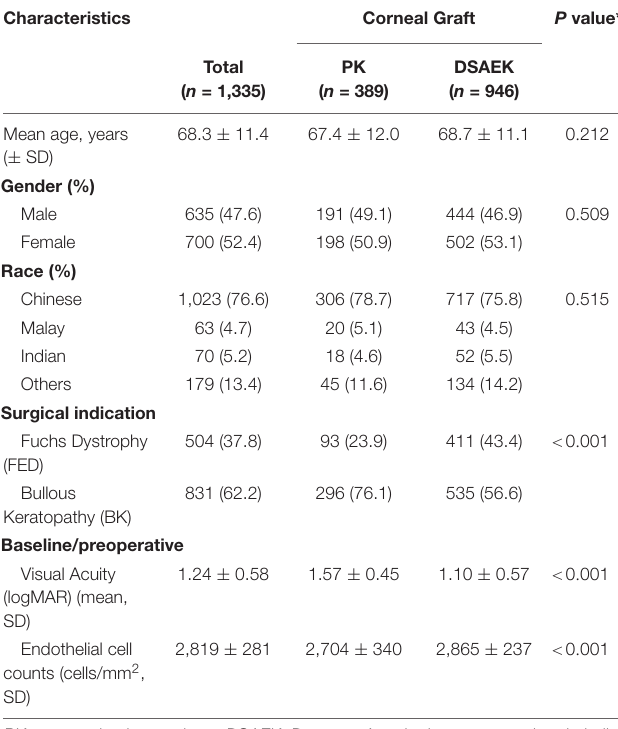
TABLE 1 | Baseline characteristics of study cohort comparing penetrating keratoplasty (PK) and Descemet stripping automated endothelial keratoplasty (DSAEK) from the Singapore Cornea Transplant